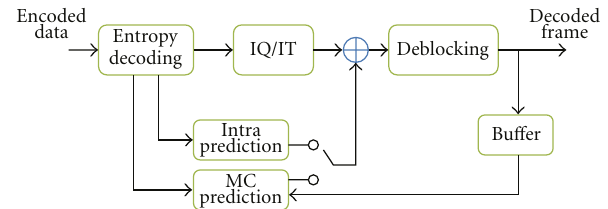
Figure 5: Functional Partition Decode